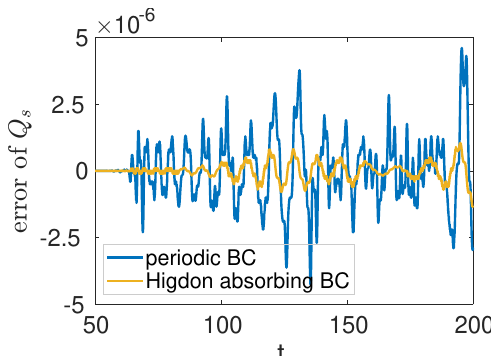
Figure 3 . Evolution of the Q s charge (see text below figure 2 for its definition) for simulations with the periodic boundary condition and the 2nd order Higdon absorbing boundary condition. The “error of Q ” is the error/deviation of Q in the simulation with the periodic or absorbing boundary s s condition, as compared with a reference simulation where the waves have not propagated to the boundary of a larger simulation box at the end of the